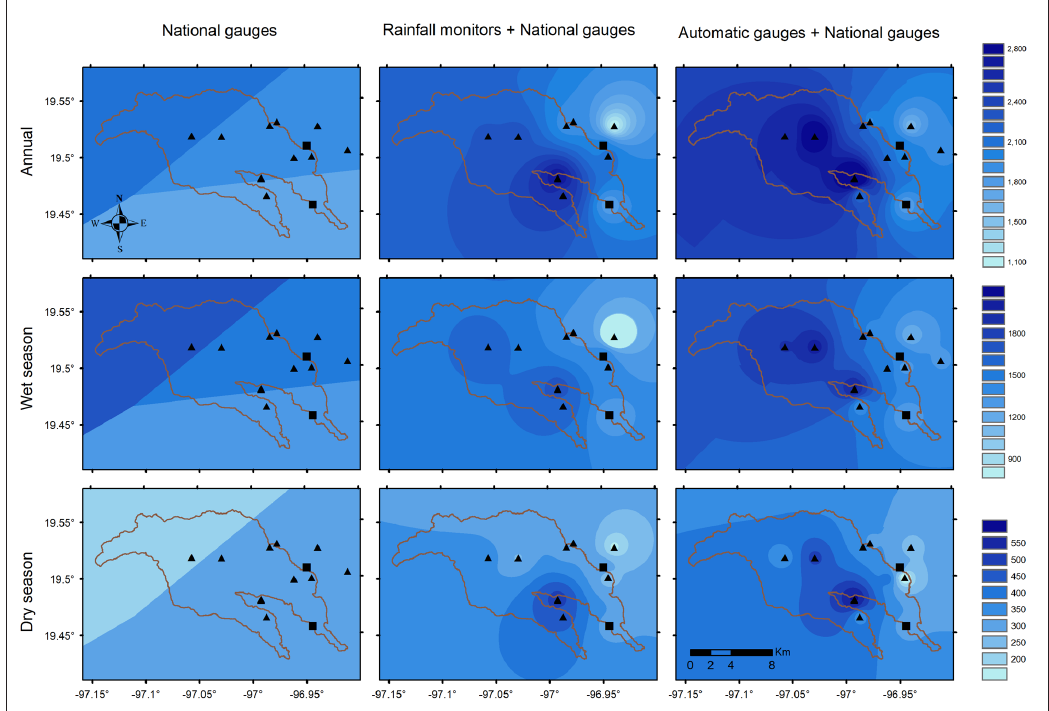
Figure 3: Annual, wet-season (November 2017–May 2018), and dry-season (June–October 2017) rainfall distributions (in millimeters) from the national climate stations alone, from volunteer rainfall data plus the national climate sta- tions, and from the automatic gauge data plus the national climate stations. Squares and triangles indicate the loca- tion of the national and monitor-automatic gauges, respectively.